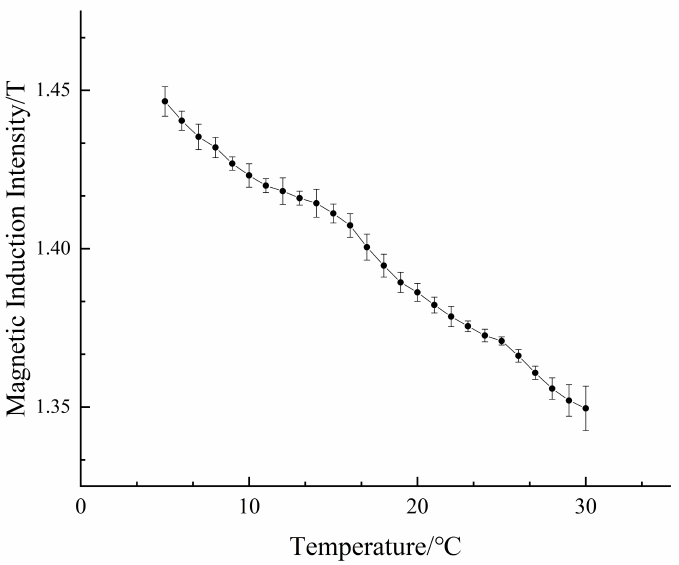
Figure 18. Actual operating temperature characteristic curve of the magnetized drive coil. The comparison of the actual measured data with the simulated data is shown in Figure 19. From the curves in Figure 19, it can be seen that the simulated data fit better with the actual measured data, which indicates that the empirical model established by the simulation is correct. All the experimental results can prove that the design is reasonable, and the magnetic induction strength of the magnetized drive coil can meet the experimental